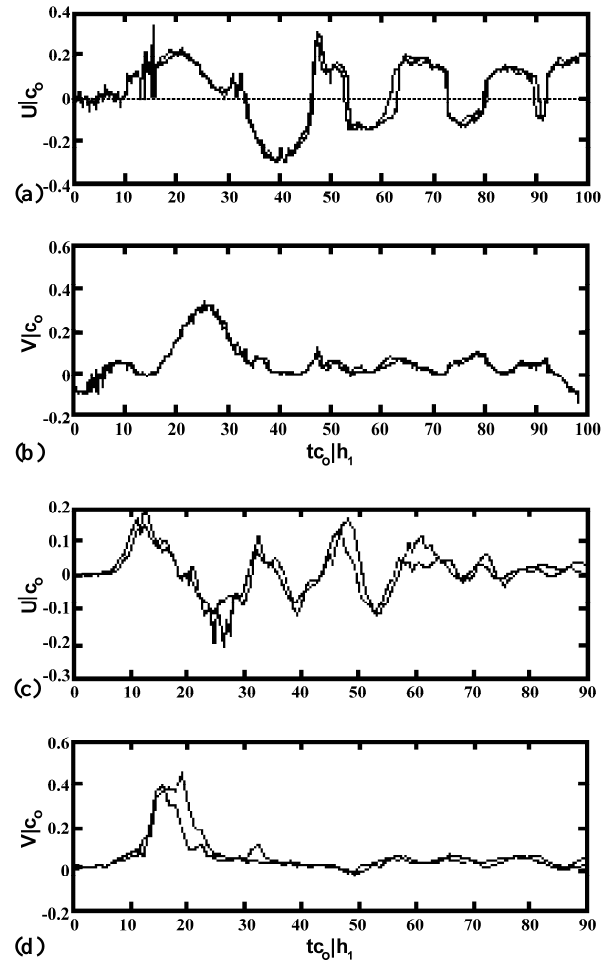
Fig. 15. Time series of transverse U (normal to the shelf) and longi- tudinal V (along the shelf) velocity components in two close points at the shelf edge (two curves in each panel) (camera 2; x = 6 . 8m, y = 0 . 17m): a , b – the “shallow” shelf; c , d – the “deep” shelf.